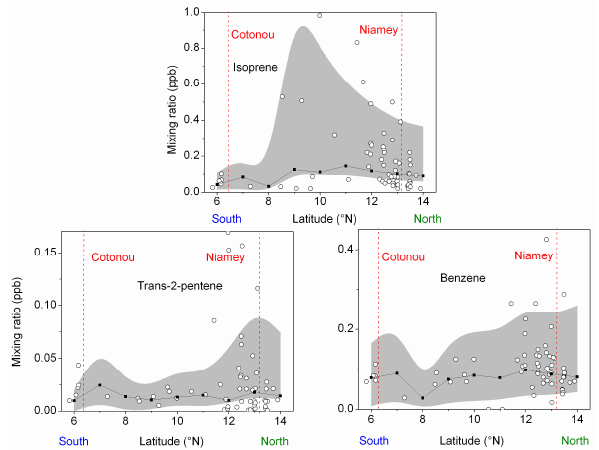
Fig. 2. North-to-South variability profiles of biogenic and anthro- pogenic NMHC in the low troposphere ( < 2km). Samples are col- Fig. 2: North-to-South variability profiles of biogenic and anthropogenic NMHC in the low lected on-board the ATR-42. Top panel shows isoprene, bottom left troposphere (< 2 km). panel shows trans-2-pentene and down right shows benzene. Open Samples are collected on-board the ATR-42. Top panel shows isoprene, bottom left panel markers denote all observations. Solid markers represent the aver- shows trans-2-pentene and down right shows benzene. Open markers denote all observations. age value in each latitudinal bins of 1 ◦ latitude. Grey area represents Solid markers represent the average value in each latitudinal bins of 1° latitude. Grey area standard deviations for all represents standard deviations for all observations.